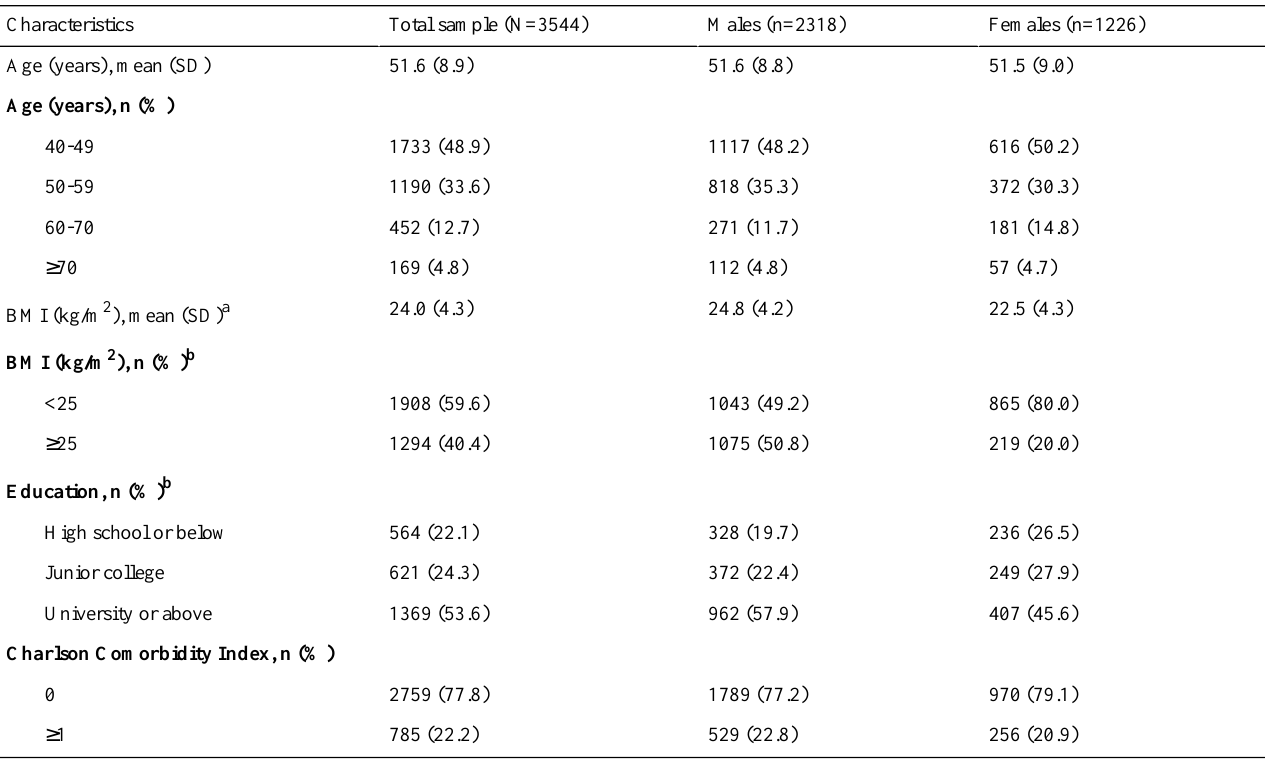
Table 1. Baseline characteristics of included